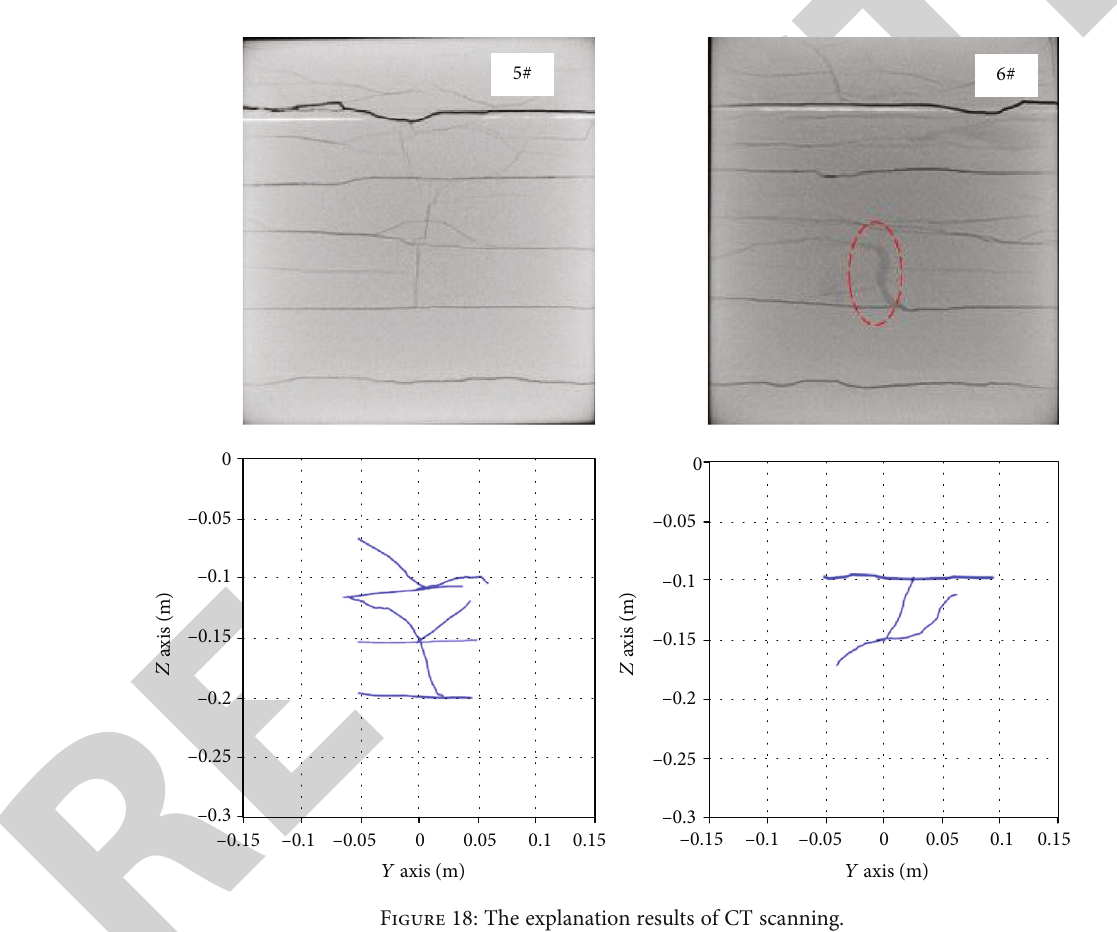
Figure 18: The explanation results of CT